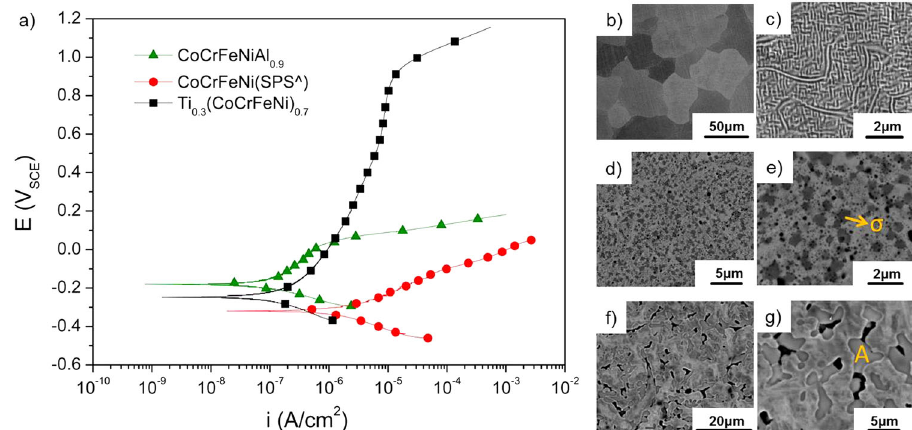
Fig. 5 a Polarisation curves for as-cast CoCrFeNiAl 0.9 , CoCrFeNi and Ti 0.3 (CoCrFeNi) 0.7 in 0.6 M NaCl at 25 ◦ C, b BSE image of CoCrFeNiAl 0.9 at low magni fi cation, c BSE image of CoCrFeNiAl 0.9 at higher magni fi cation , d BSE image of CoCrFeNi at low magni fi cation; this alloy was produced using spark plasma sintering, e BSE image of CoCrFeNi at higher magni fi cation, f BSE image of Ti 0.3 (CoCrFeNi) 0.7 at low magni fi cation, g BSE image of Ti